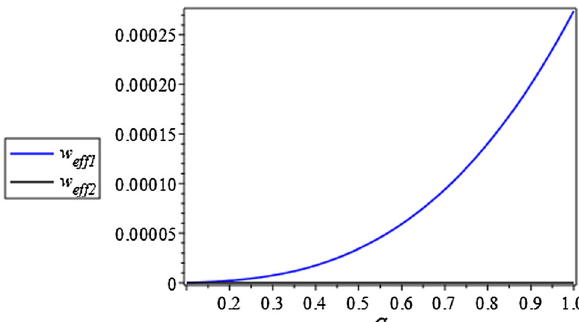
Fig. 9 w ef f ( 1 , 2 ) versus a for dust-torsion system for GCG. We use c = 2 and A = 0 . 98 for all numerical